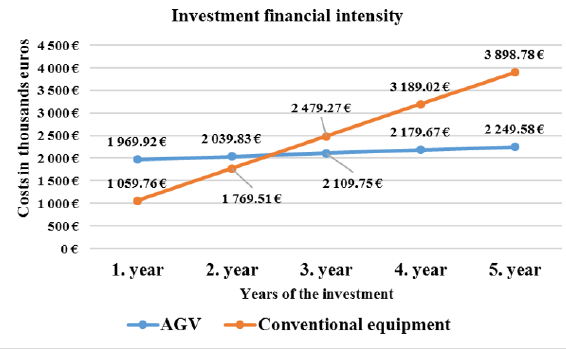
Figure 1: Graphical representation of the financial intensity calcula- tion.